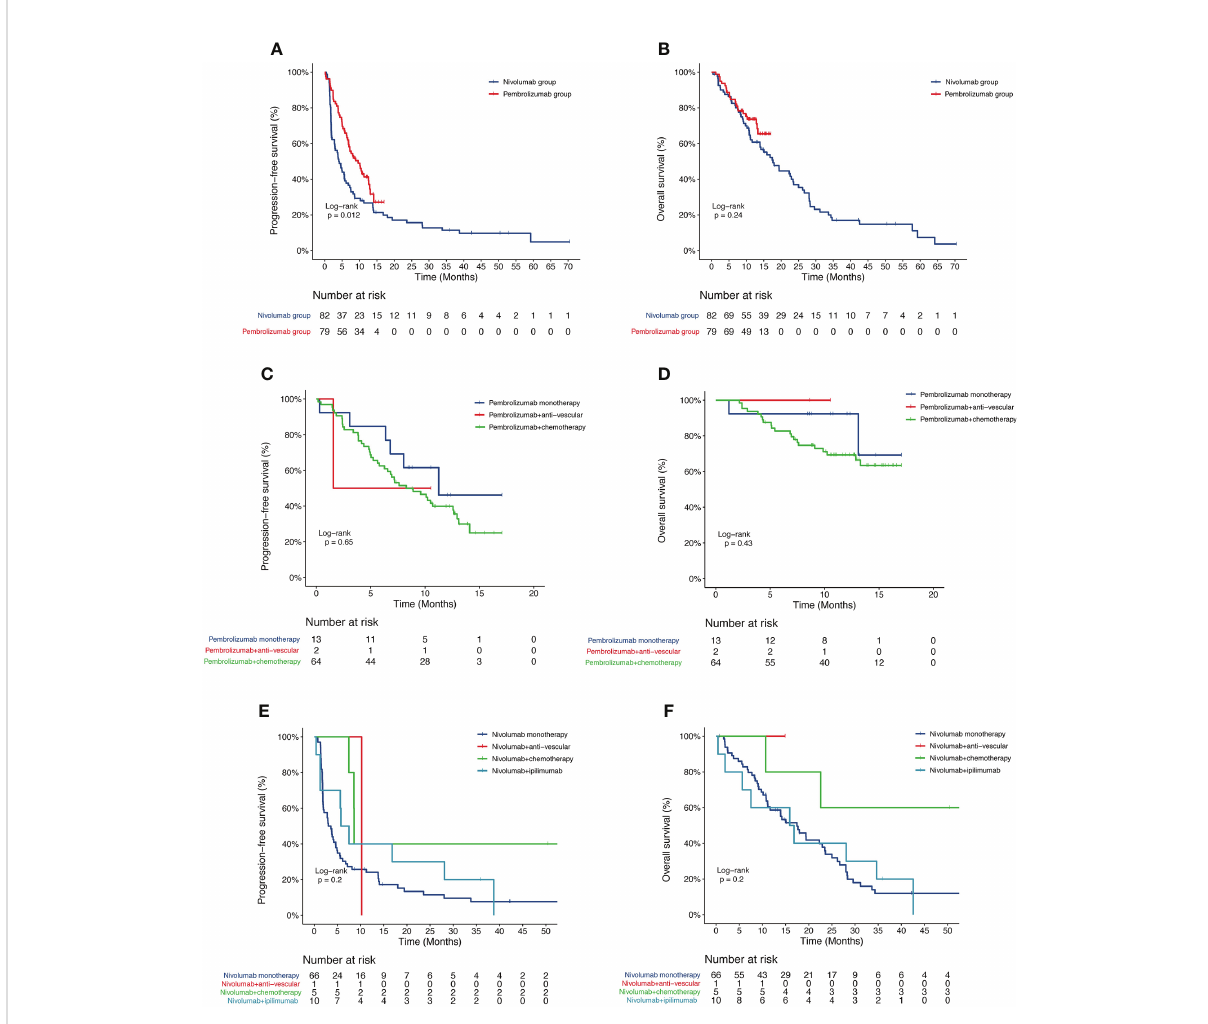
FIGURE 1 Kaplan-Meier curve of PFS and OS of 161 patients. (A) PFS and (B) OS of patients strati fi ed with nivolumab and pembrolizumab; (C) PFS and (D) OS of patients strati fi ed with pembrolizumab monotherapy, pembrolizumab plus anti-vascular therapy and pembrolizumab plus chemotherapy; (E) PFS and (F) OS of patients strati fi ed with nivolumab monotherapy, nivolumab plus anti-vascular therapy, nivolumab plus chemotherapy and nivolumab plus ipilimumab therapy. PFS, progression-free survival; OS, overall